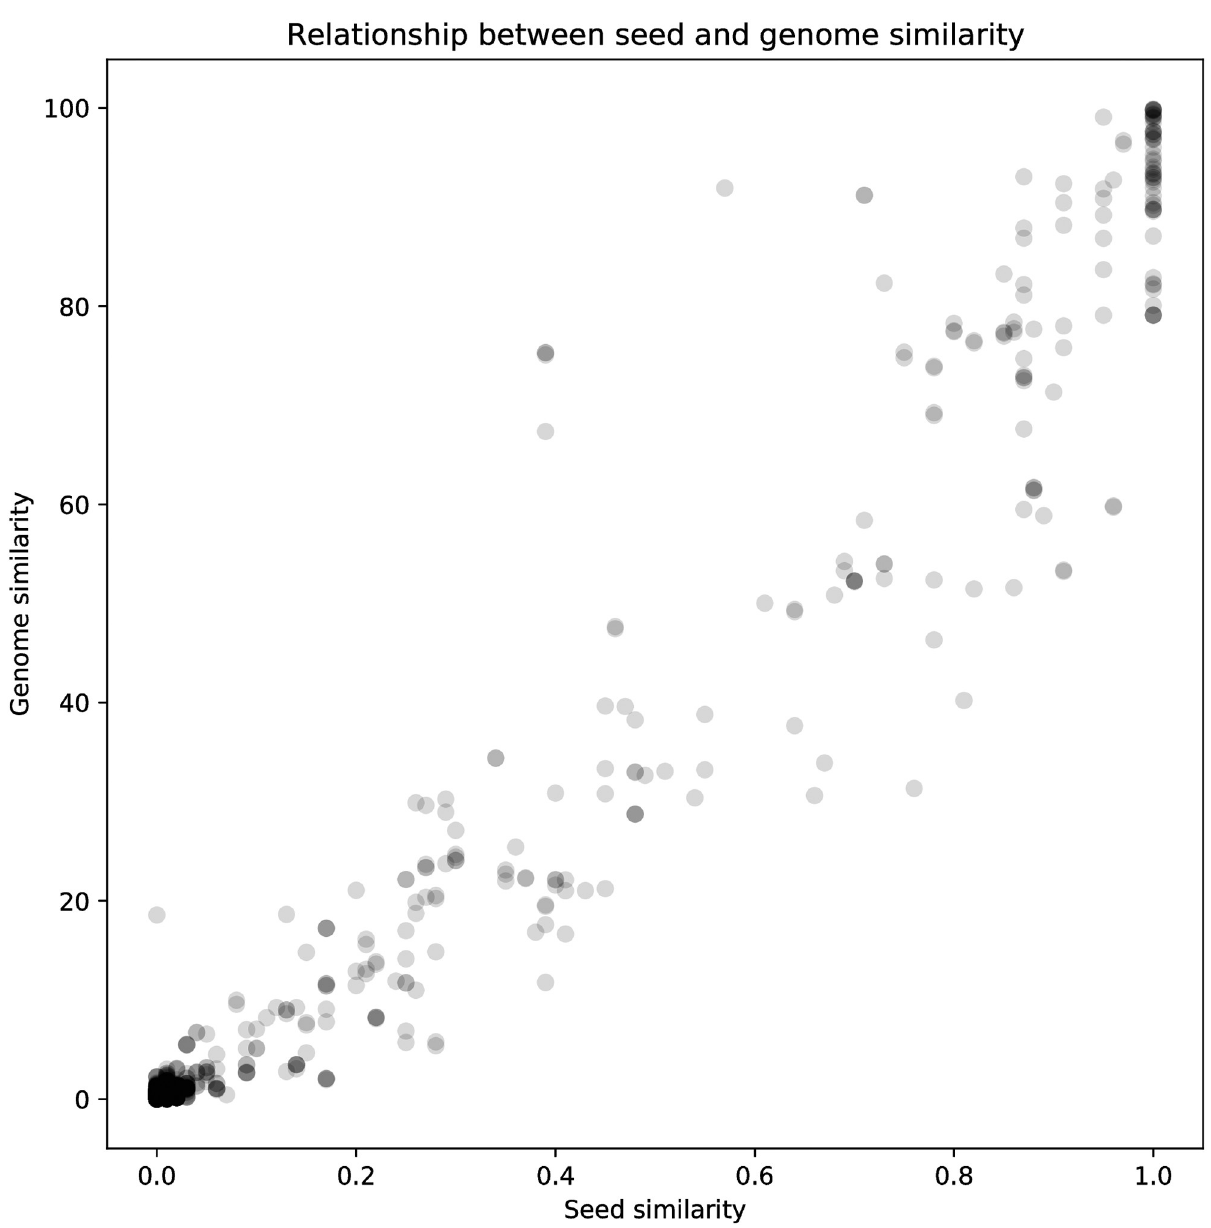
Fig 5. Relationship between distance to seed protein and genome similarity. This is a comparison used to determine the correspondence between pheS distance and mutations in the genome. The “similarity” number is the percent of known (i.e. annotated, non-hypothetical) roles that match. So, given one of the 11,533 roles in subsystems, if it occurs in both genomes, we compare the kmers in common to get a percent match. If it occurs in only one of the genomes, it is considered to have a similarity of 0%. This is all accumulated into a percentage protein similarity over the whole genome. If the similarity is listed as 0.50, note it means the match is one-half of one percent, not fifty percent. The pearson coefficient is 0.97, which means there is almost a one-to-one correspondence between role similarity in the genomes and pheS similarity